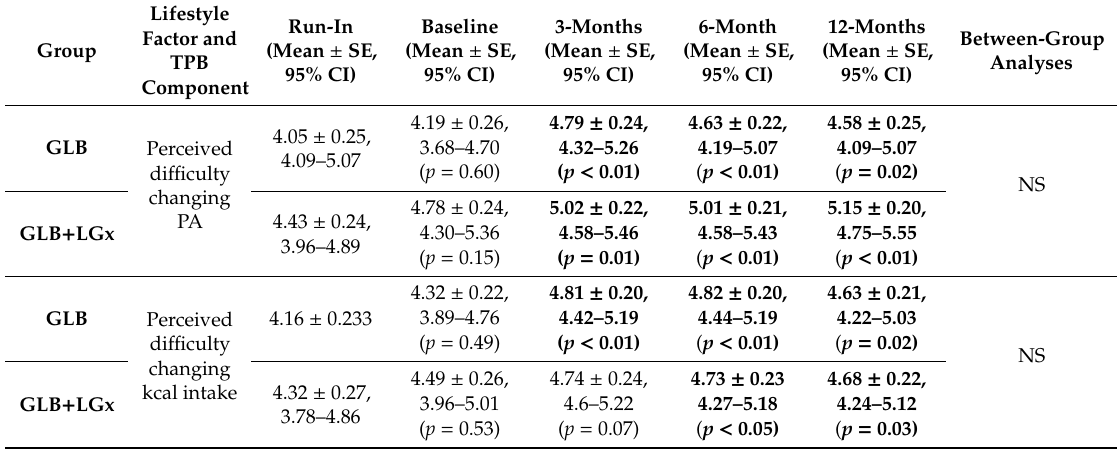
Table 3. Change in perceived behavioural control by intervention group over 12-month